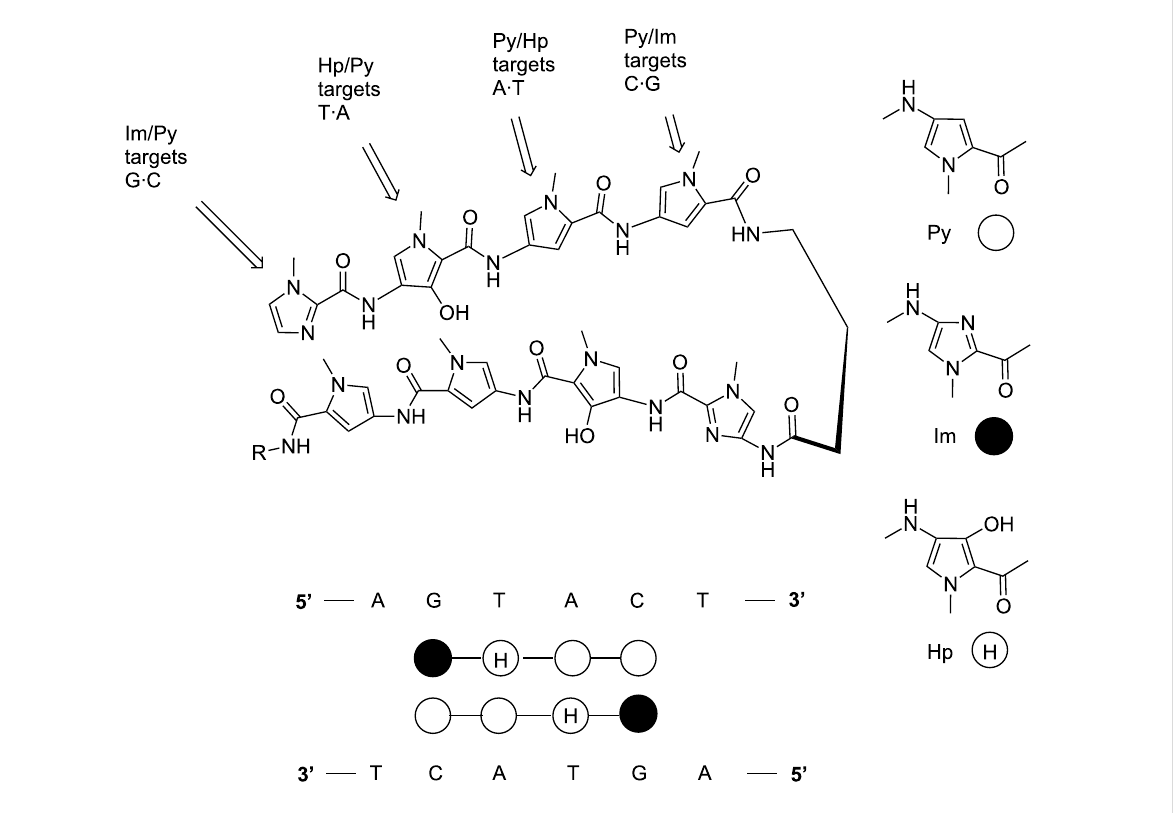
Figure 5: Pictorial representation of the binding model of pyrrole–imidazole (Py/Im) polyamides based on the base pairing recognition rule in the minor groove.